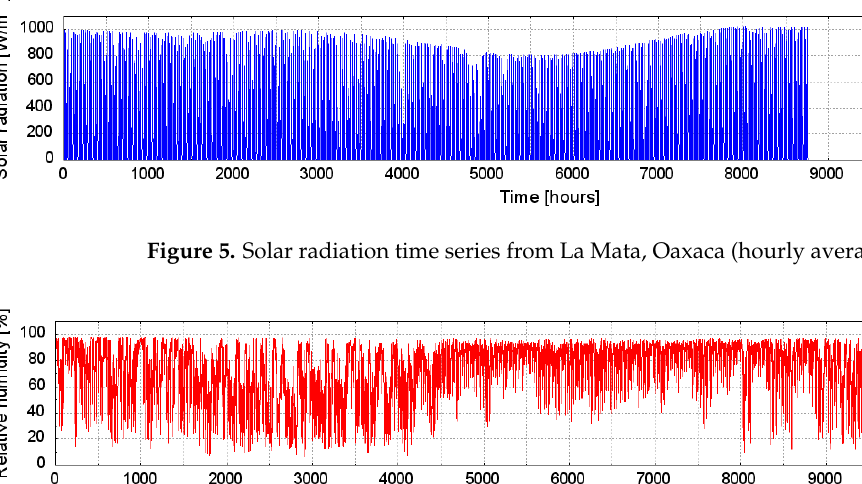
Table 1. Descriptive statistics of the involved variables of La Mata. WS, wind speed; WD, wind direction; T, temperature; P, pressure; SR, solar radiation.